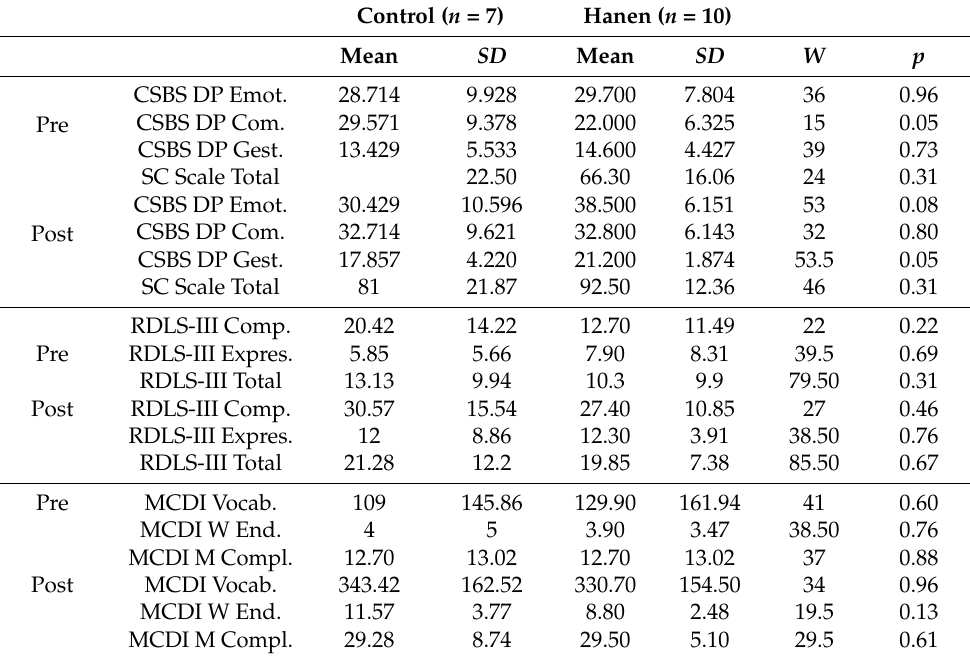
Table 3. Descriptive statistics related to children and Mann-Whitney nonparametric U test across groups.